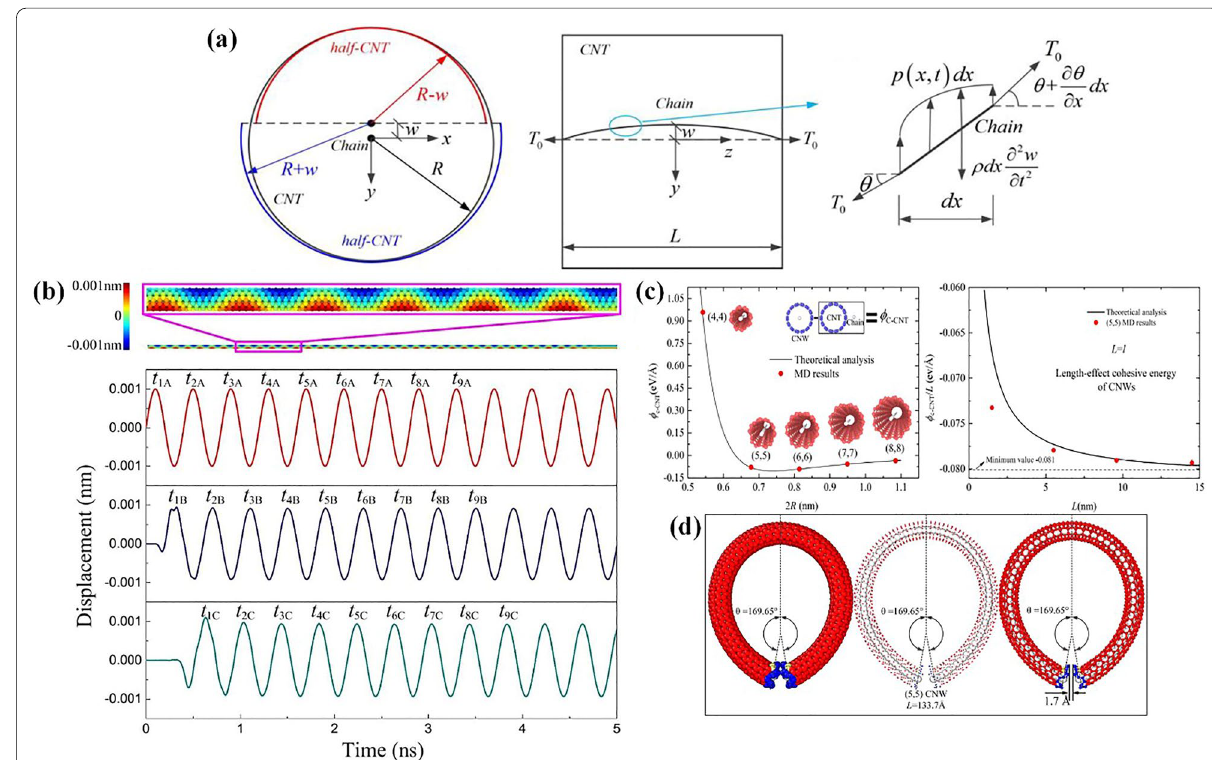
Figure 6 ( a ) Schematic diagrams of CNTs filled with linear mass chains [62], ( b ) MD simulations of flexural wave propagation in a carbon-atom chain-filled CNT [63], ( c ) The cohesive energy and ( d ) bending behaviors of infinite filled CNTs